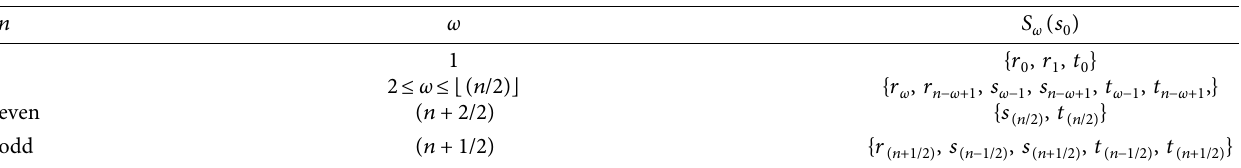
Figure 1: Convex polytope T Table 1: S